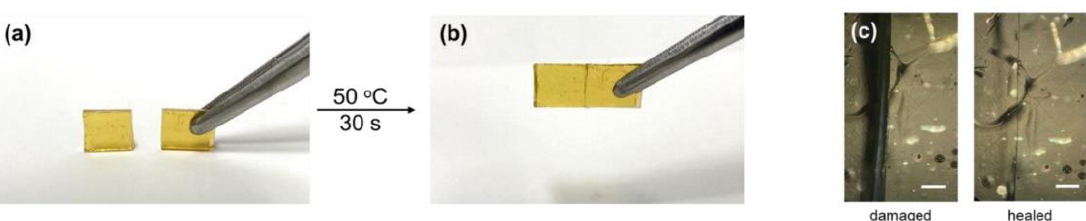
Figure 27. ( a ) POSS-B/ZnCl 2 sample cut into two pieces; ( b ) rejoined pieces after 30 s at 50 °C; ( c ) images of sample before (left) and after (right) self-healing process. Scale bar—500 µ m. Reproduced from Mater. Chem. Front. 2020, 4 , 2655–2664 [90] with permission from the Royal Society of Chemistry.